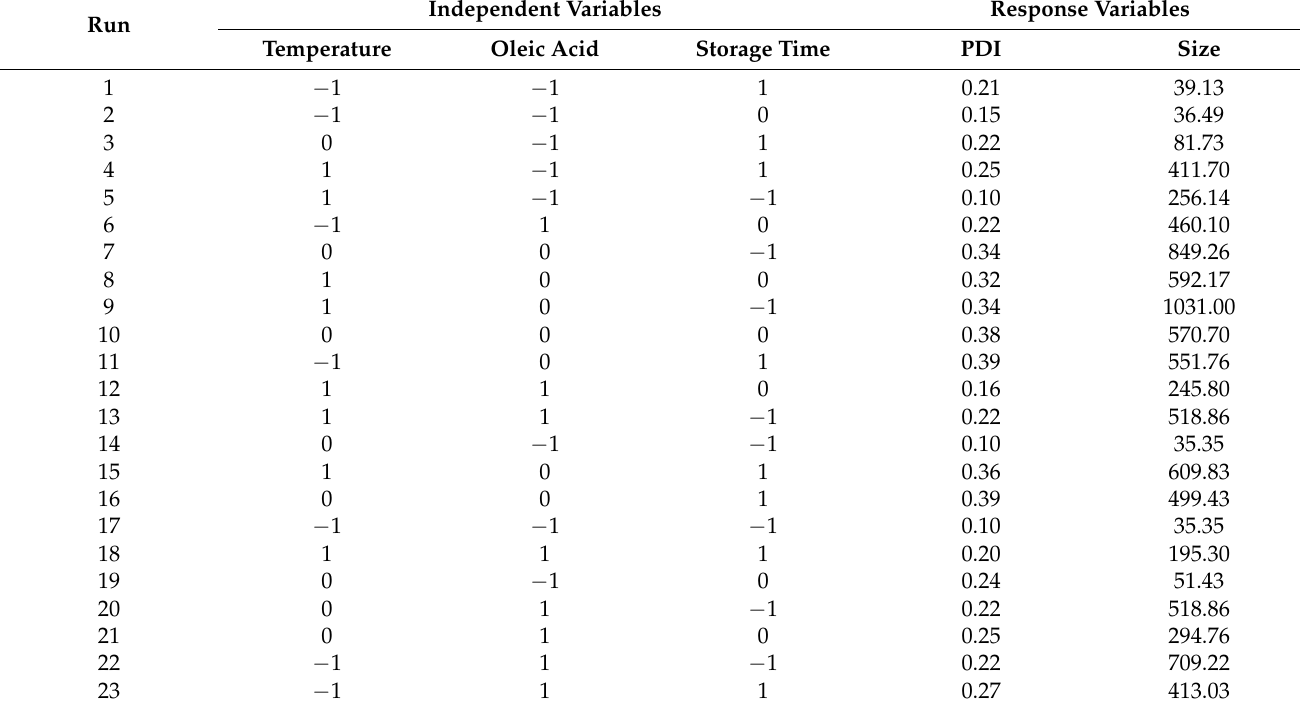
Table 3. Three-level factorial response surface design arrangement and response for SBH